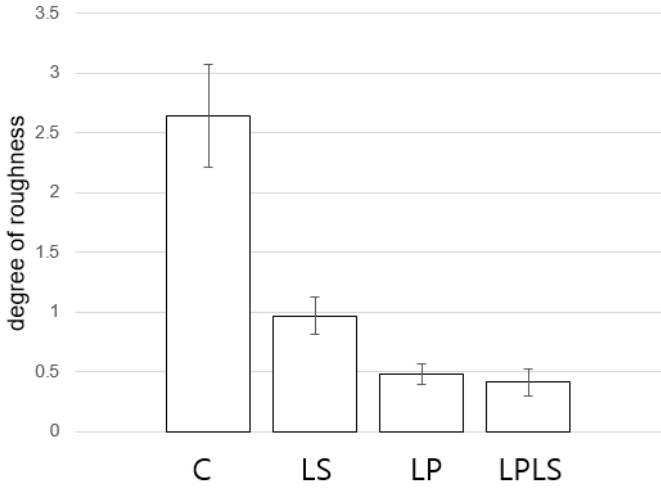
Figure 6. The degree of shell ruggedness in each group (Mean ± SE). The number of replicates for each group was eight. The degree of ruggedness decreased when the pH and salinity was low and significantly affected by those